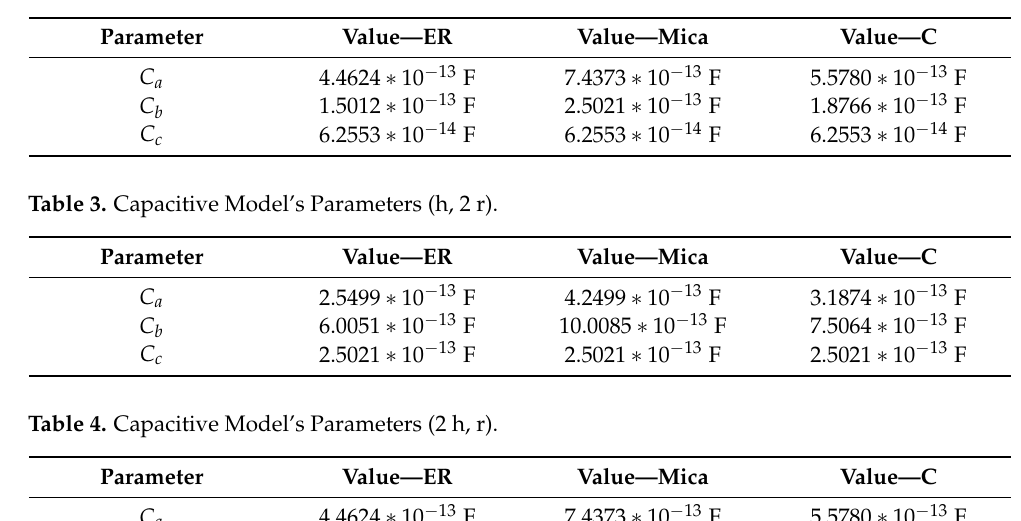
Table 2. Capacitive Model’s Parameters (h, r).